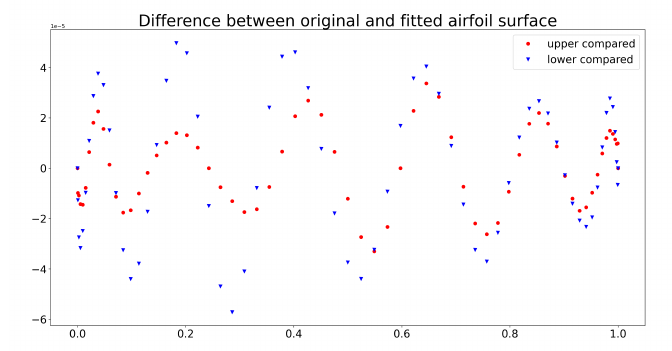
Figure 5. The difference between the original RAE2822 airfoil surface and fitted one via CST.